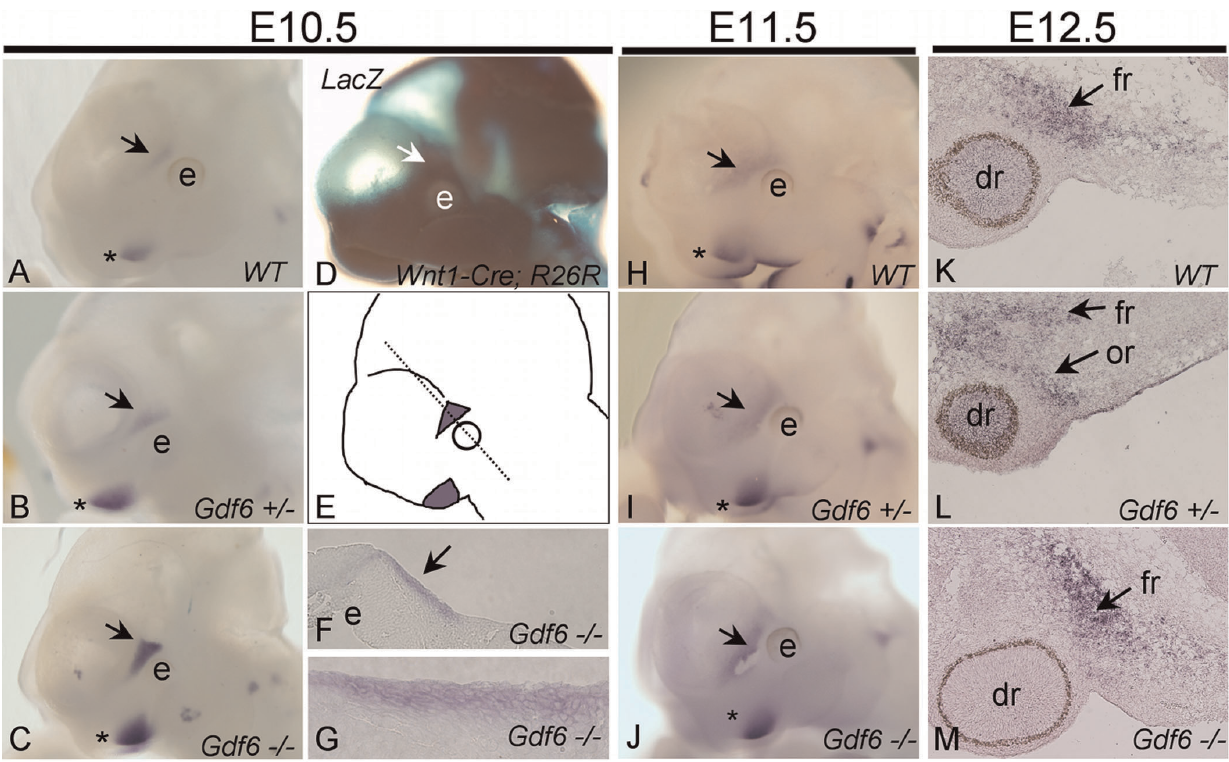
Figure 5. Expression of Gdf6 . In situ hybridization for Gdf6 at E10.5 (A–C, F,G), E11.5 (H–J), and E12.5 (K–M). Gdf6 was expressed in the frontal bone primordia (arrow), which is labeled as neural crest-derived in the Wnt1-Cre; R26R transgenic embryos (D). Gdf6 transcript was expressed more strongly in the Gdf6 2 / 2 embryo (C, J) than either the wild-type (A, H) or Gdf6 + / 2 embryo (B, I), in both the frontal bone rudiment (arrow) and branchial arches (asterix). In transverse cross section through the eye and frontal bone primordia at E10.5 (dotted line, E), Gdf6 was expressed in several layers of mesenchyme underlying the surface ectoderm (F, G). At E12.5, Gdf6 continues to be expressed in the frontal bone rudiment, in addition to the dorsal retina (K–L) and orbital bone rudiment (L). Expression of Gdf6 in the dorsal retina seen in the wild-type and Gdf6 + / 2 (K,L) was absent in the Gdf6 2 / 2 (M). dr, dorsal retina; e, eye; fr, frontal rudiment; or, orbital bone rudiment.